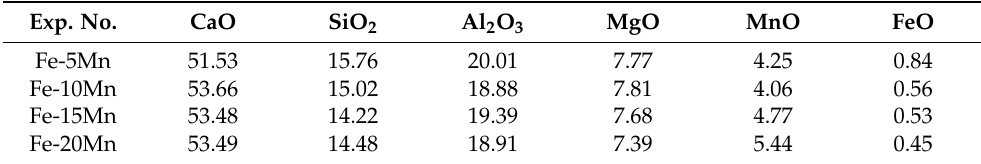
Table 2. Chemical composition of slag samples after equilibrium, mass%. Exp.